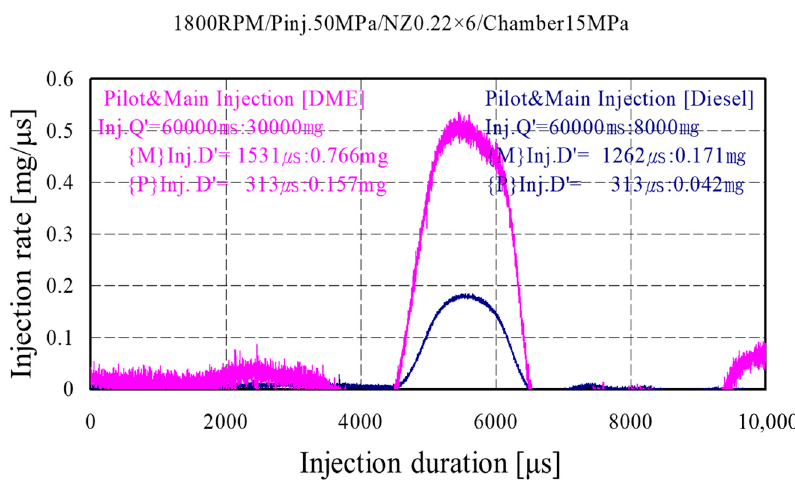
Figure 9. Injection rate characteristic for the fuel injection with and without pilot injection of the injection duration for diesel and DME.